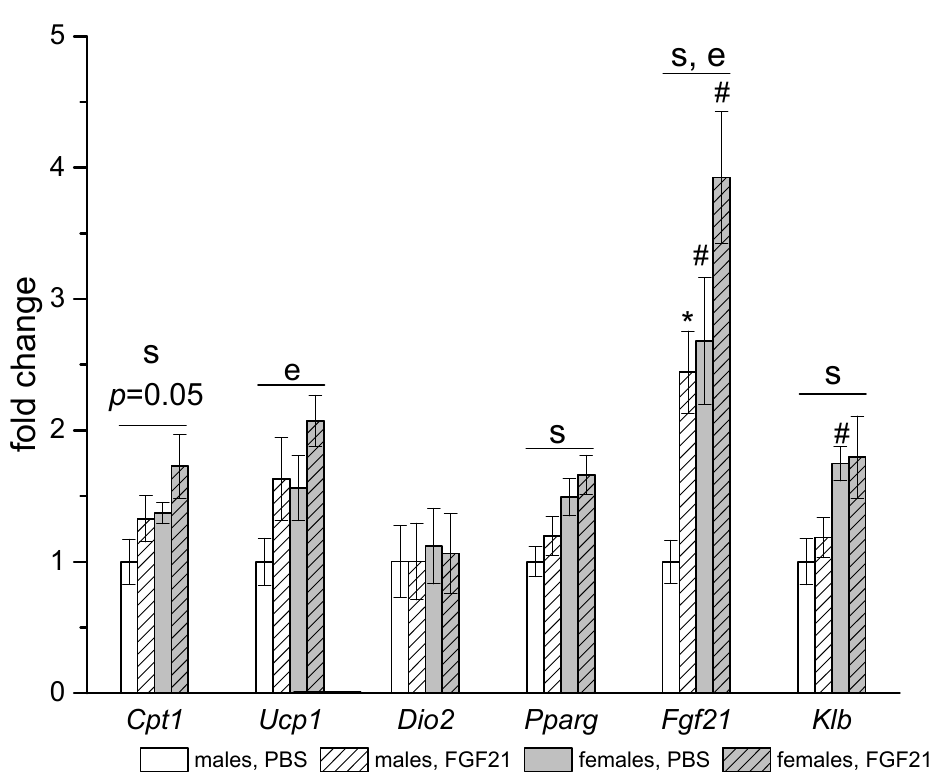
Figure 5. Influence of FGF21 administration on iBAT gene expression in obese A y male and female mice. Data are presented as mean ± SE. Mice were administered FGF21 for 7 days. Significant influence ( p < 0.05) of factors “e” (administration of PBS or FGF21), “s” (sex), two-way ANOVA are indicated in the plot.